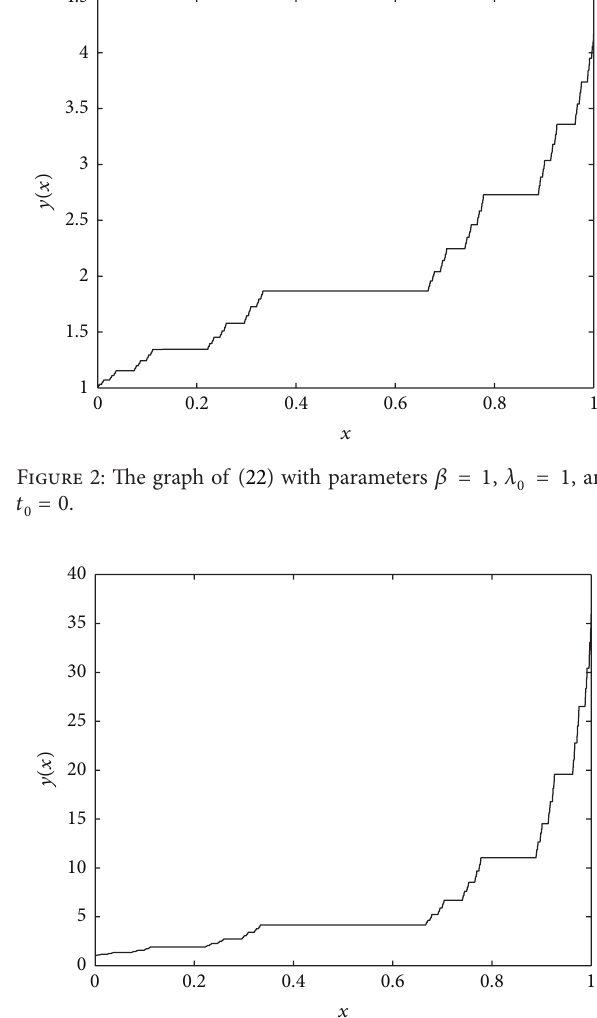
Figure 3: The graph of (22) with parameters 𝛽 = 1 , 𝜆 0 = 2 , and = 0 𝑡 0